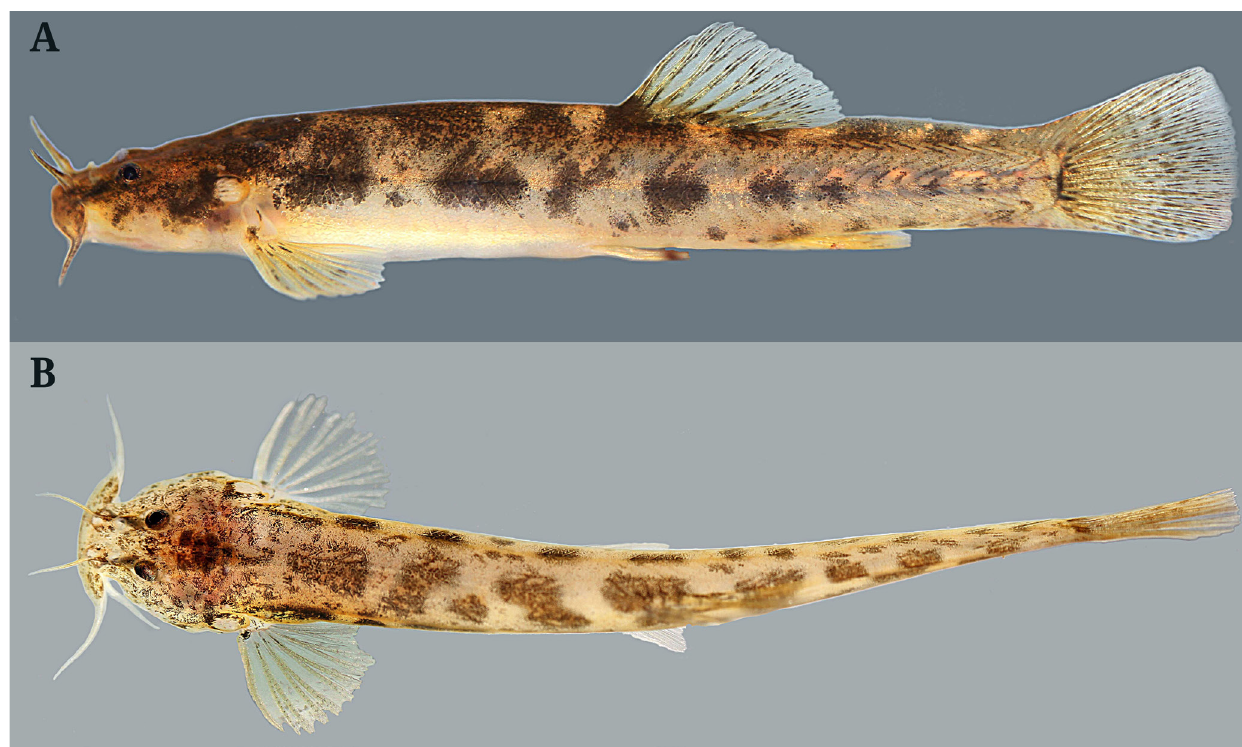
FIGURE 18 | Specimens in life of Scleronema minutum ( A. UFRGS 22100; 37.4 mm SL, Santana da Boa Vista, arroio das Neves, B. UFRGS 22128; 39.4 mm SL, arroio Igrejinha), Brazil, Rio Grande do